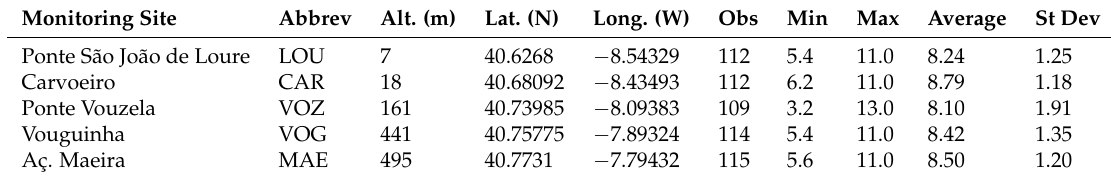
Table 1. Descriptive statistics of dissolved oxygen concentration between January 2002 and May